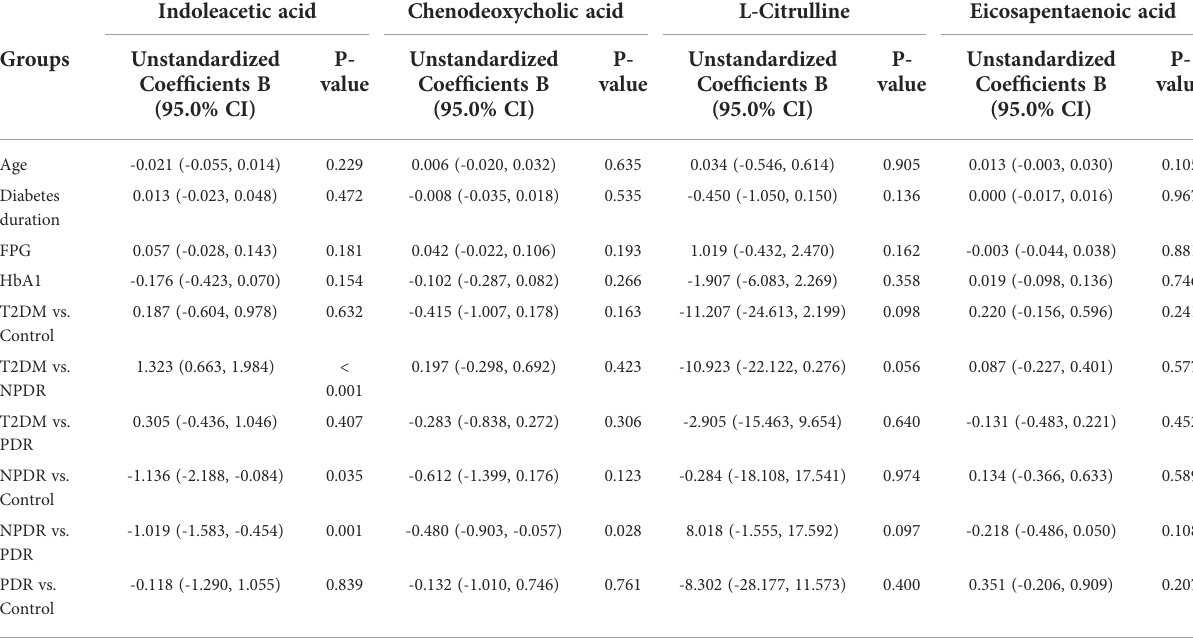
TABLE 4 The multiple linear regression result of the differential metabolites between